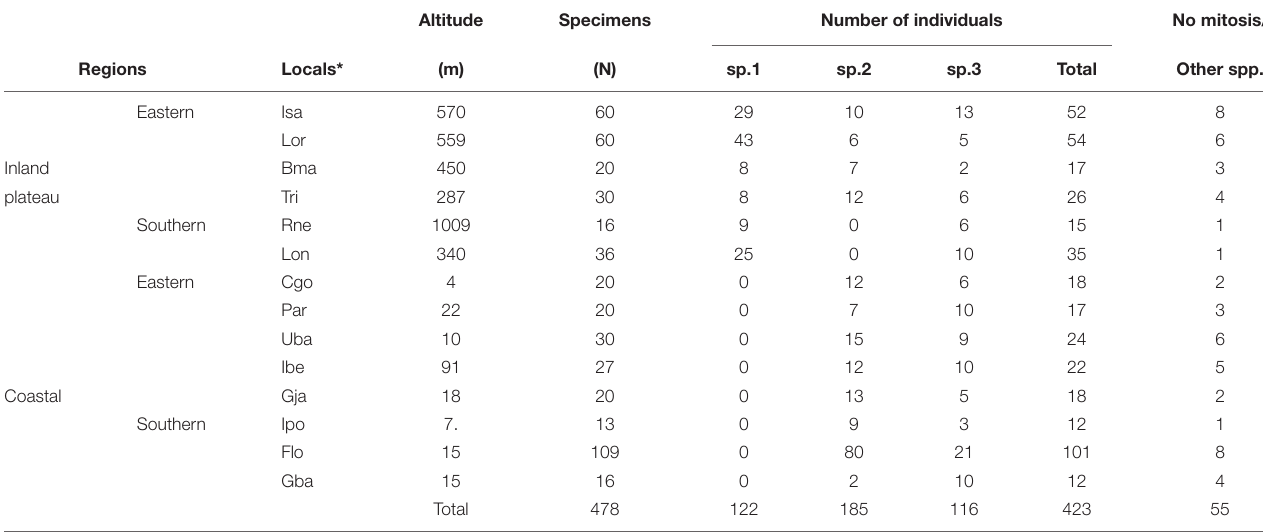
Altitude Specimens